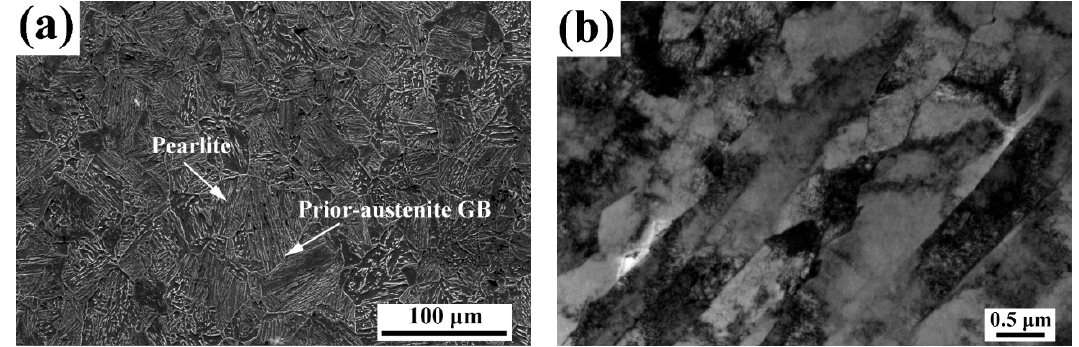
Figure 2. Microstructures of the sample before heating: ( a ) SEM morphology; ( b ) TEM morphology.